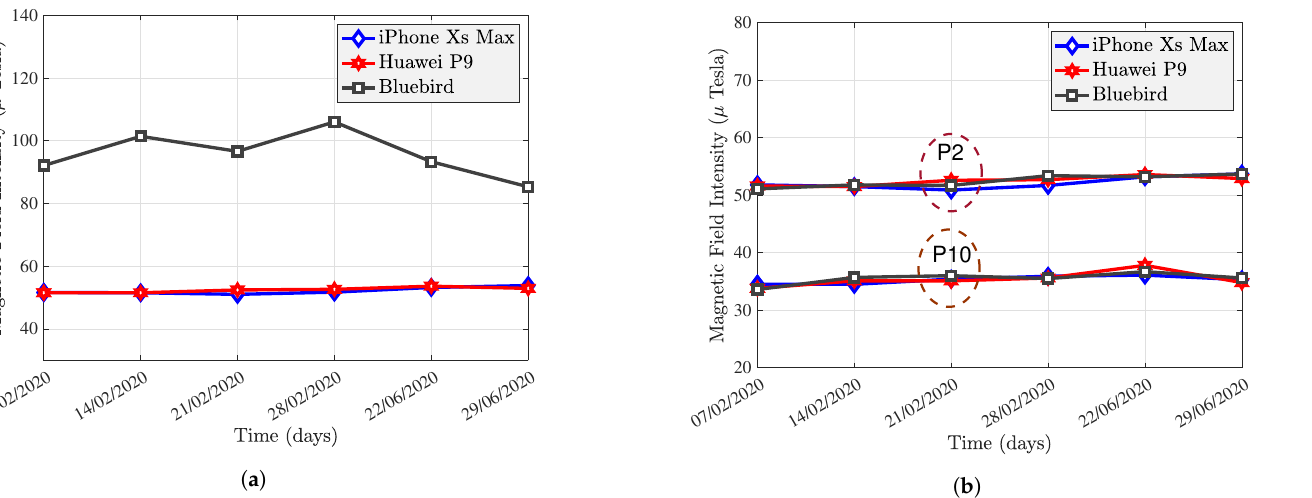
Figure 12. Comparison of heterogeneous smartphones. ( a ) Uncalibrated MF measurement of P2. ( b ) Calibration result of P2 and